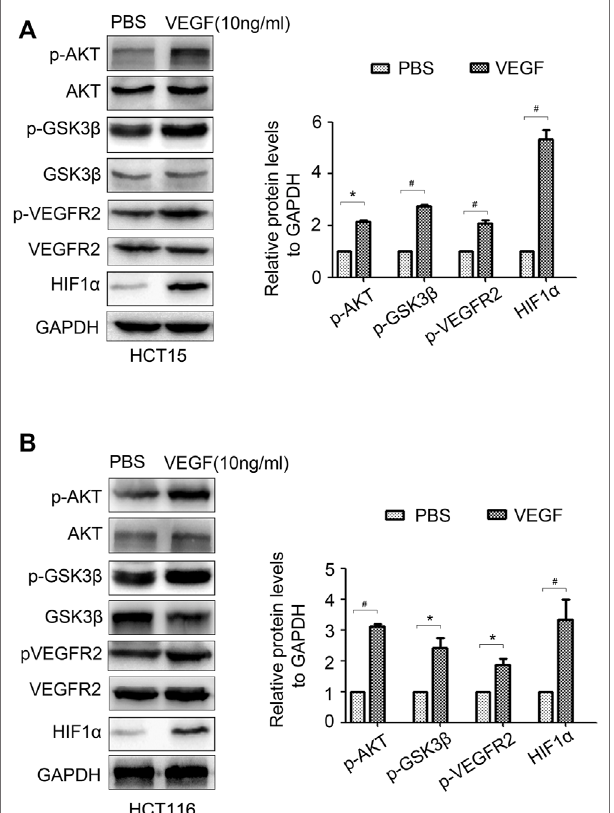
FIGURE 7 | VEGF feedback regulates HIF1 α expression in CRC cells. (A,B) Theexpression of p -AKT,AKT, p -GSK3 β ,GSK3 β , p -VEGFR2, VEGFR2 and HIF1 α in HCT15 and HCT116 cells treated with PBS or VEGF (10 ng/ml) for 24 h were detected by WB. *: p < 0.05, #: p < 0.01.